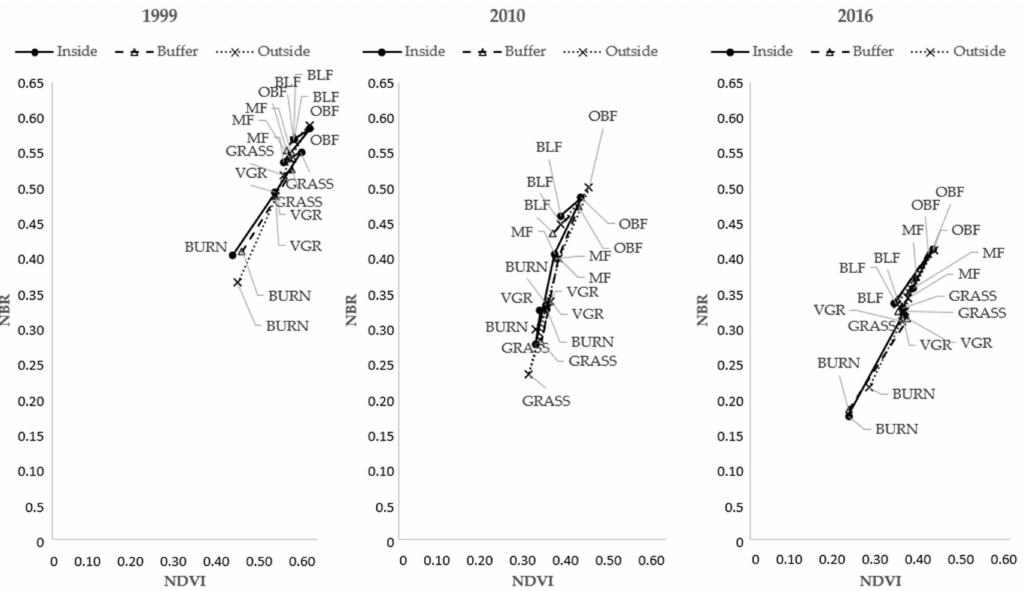
Figure 8. NDVI versus normalized burn ratio (NBR) inside, buffer zone, and outside of the reserve in 1999, 2010, 2016. BURN = burned area, VGR = vegetation recovery, GRASS = grassland, MF = mixed forests, OBF = oak–Daurian birch forests, and BLF = birch and larch